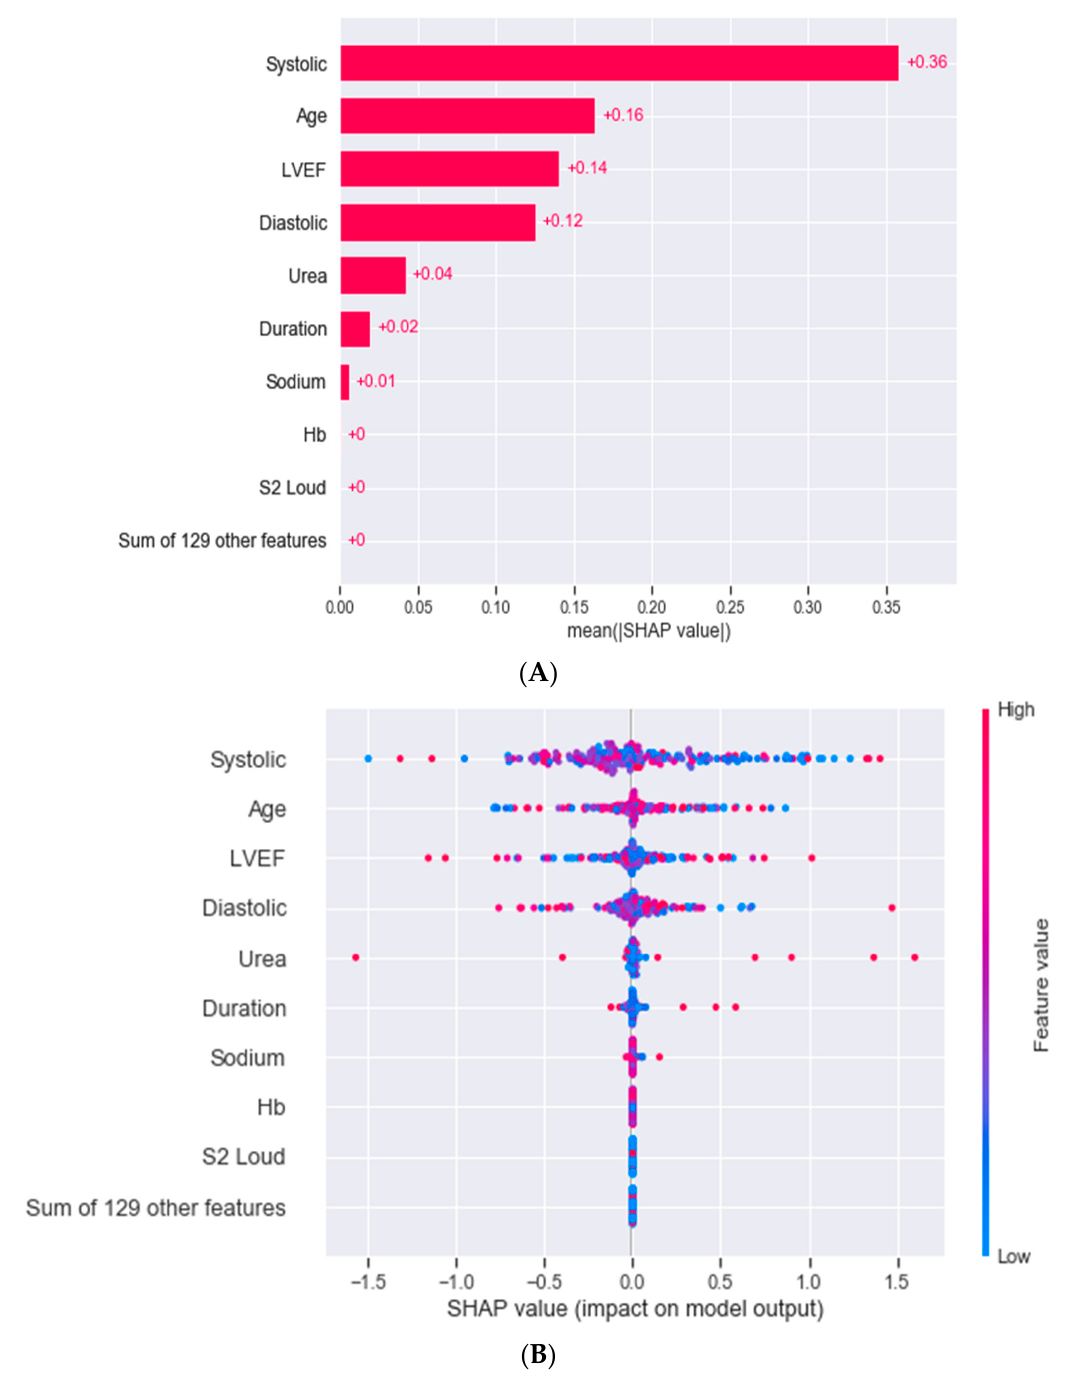
Figure 3. Features identified with Shapley additive explanations (SHAP) that played a role in the segmentation of the heart failure cohort into three clusters using the agglomerative clustering algorithm. ( A ) Bar plot depicting the importance of each feature. The higher the mean weight, the higher the contribution of the feature. ( B ) Bee swarm plot showing the contribution of the top eight features. Each dot represents a single patient. Red and blue refer to high and low feature values, respectively. Both high and low values of the systolic and diastolic blood pressure, age, and LVEF contributed towards clustering patients. Hb = haemoglobin; LVEF = left ventricular ejection fraction; S2 = second heart sound.